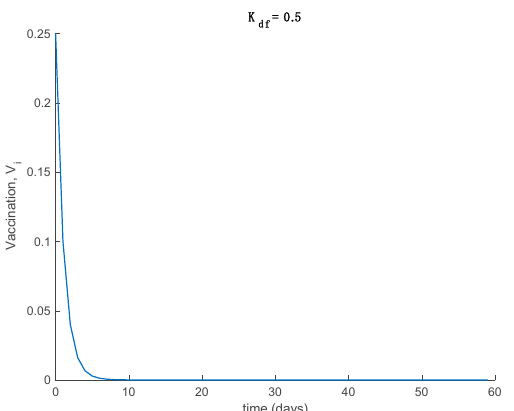
gardless of the initial values. Figure 3. Vaccination control action for K df = 0.2 and K df = 0.5. Figure 3. Vaccination control action for 20 .K df = and 50 .K df = .